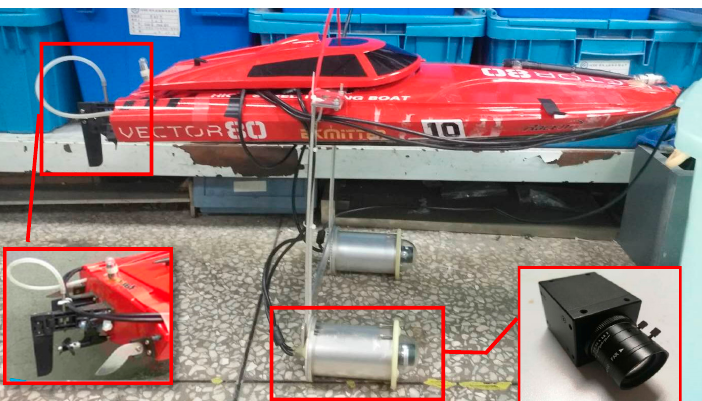
Figure 15. The ship model used in this experiment.